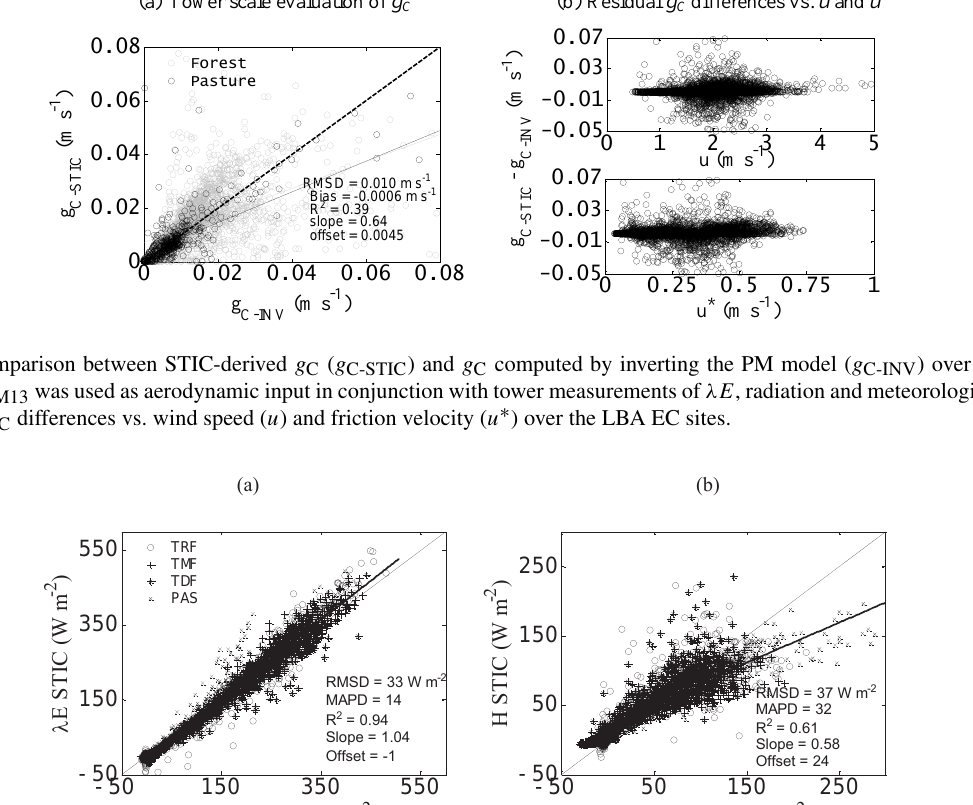
( r = − 0.29 to − 0.45) between (1 − (cid:127) ) and λE E (Fig. 5b)